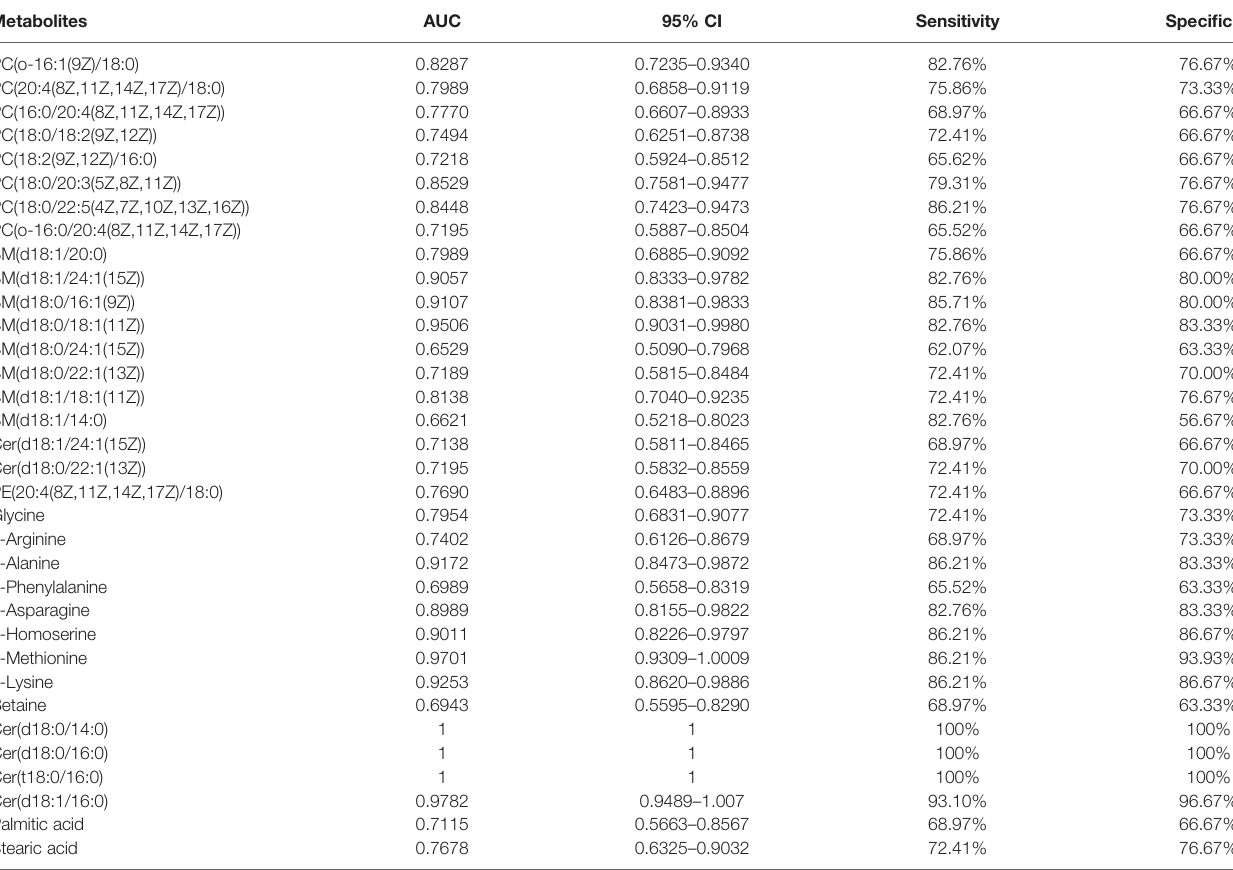
TABLE 4 | Diagnostic test information of metabolites between TB vs. HC and TB vs. DC.